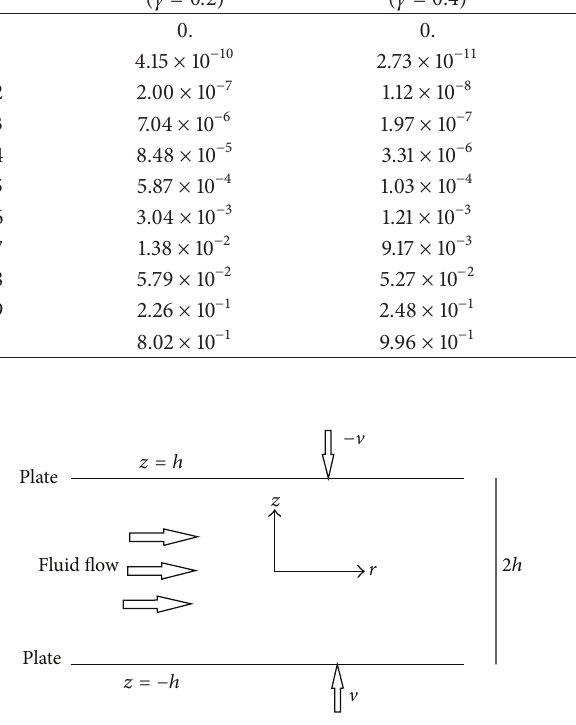
Figure 1: Squeezing flow of Newtonian fluid between two large parallel